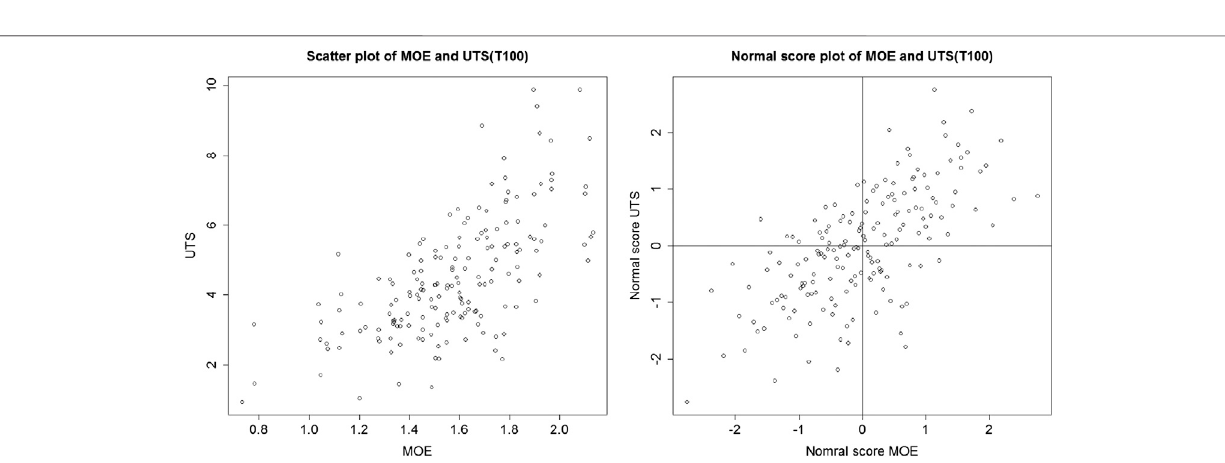
FIGURE 2 | Left: scatterplot of ( MOE , UTS ) based on T100. Right: normal scores plot of ( MOE , UTS ) based on T100.